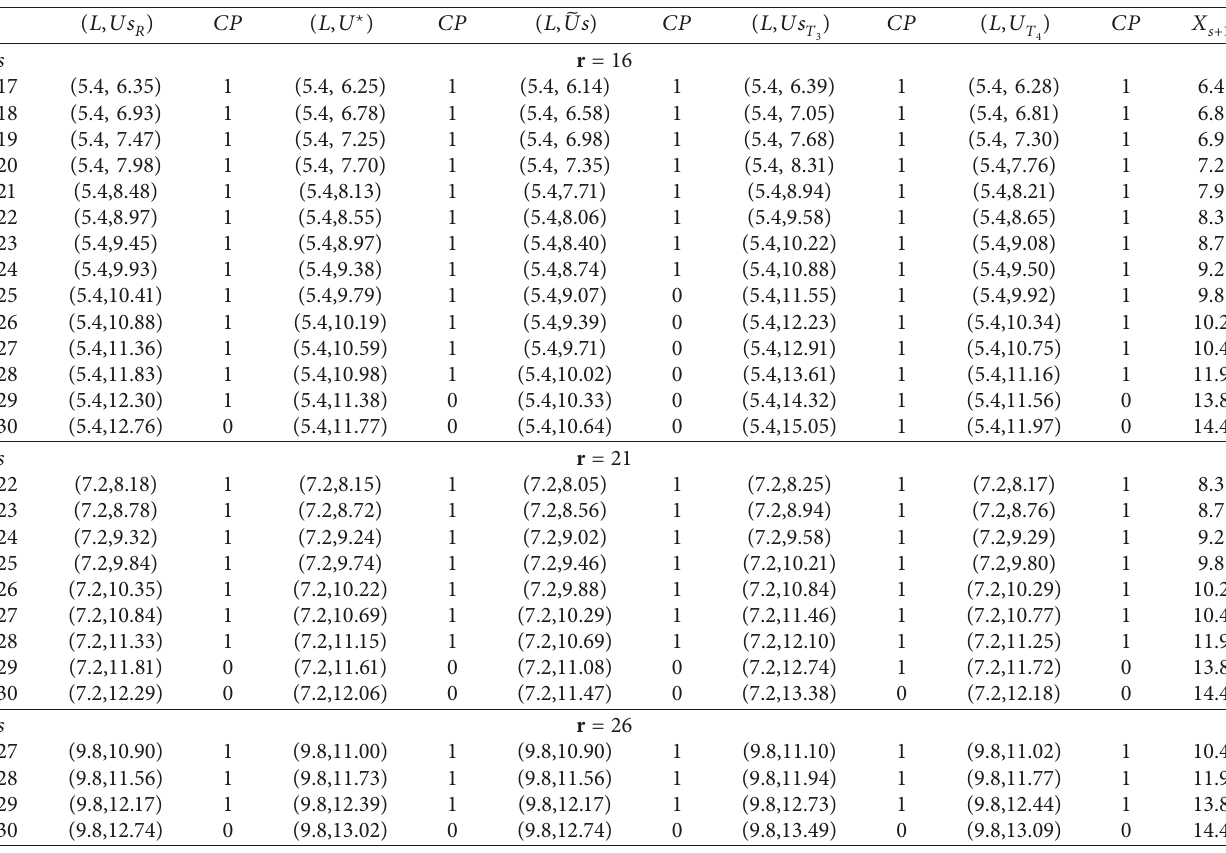
, . .. , x r : 107 when 1 : 107